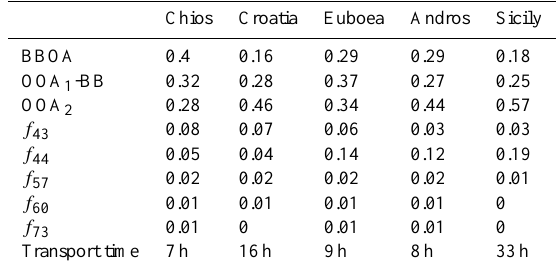
Table 1. Relative contribution of each one of the three identified PMF factors to the OA and relative intensity of characteristic mark- ers in each fire